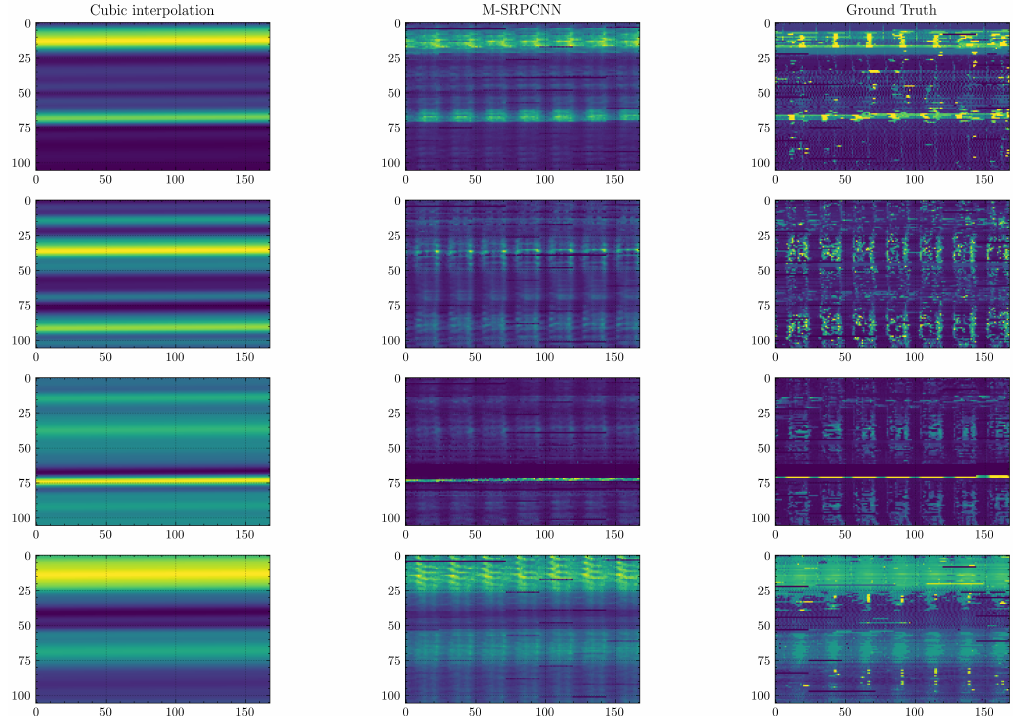
Figure 6. Consumption heatmap representation of cubic interpolation, M-SRPCNN prediction and ground truth, in order from left to right, of random samples from the test set of SMARKIA SRP dataset. Each row in every heat-map represents one week and each column represents an hour. The lighter color, the higher consumption. Best viewed in